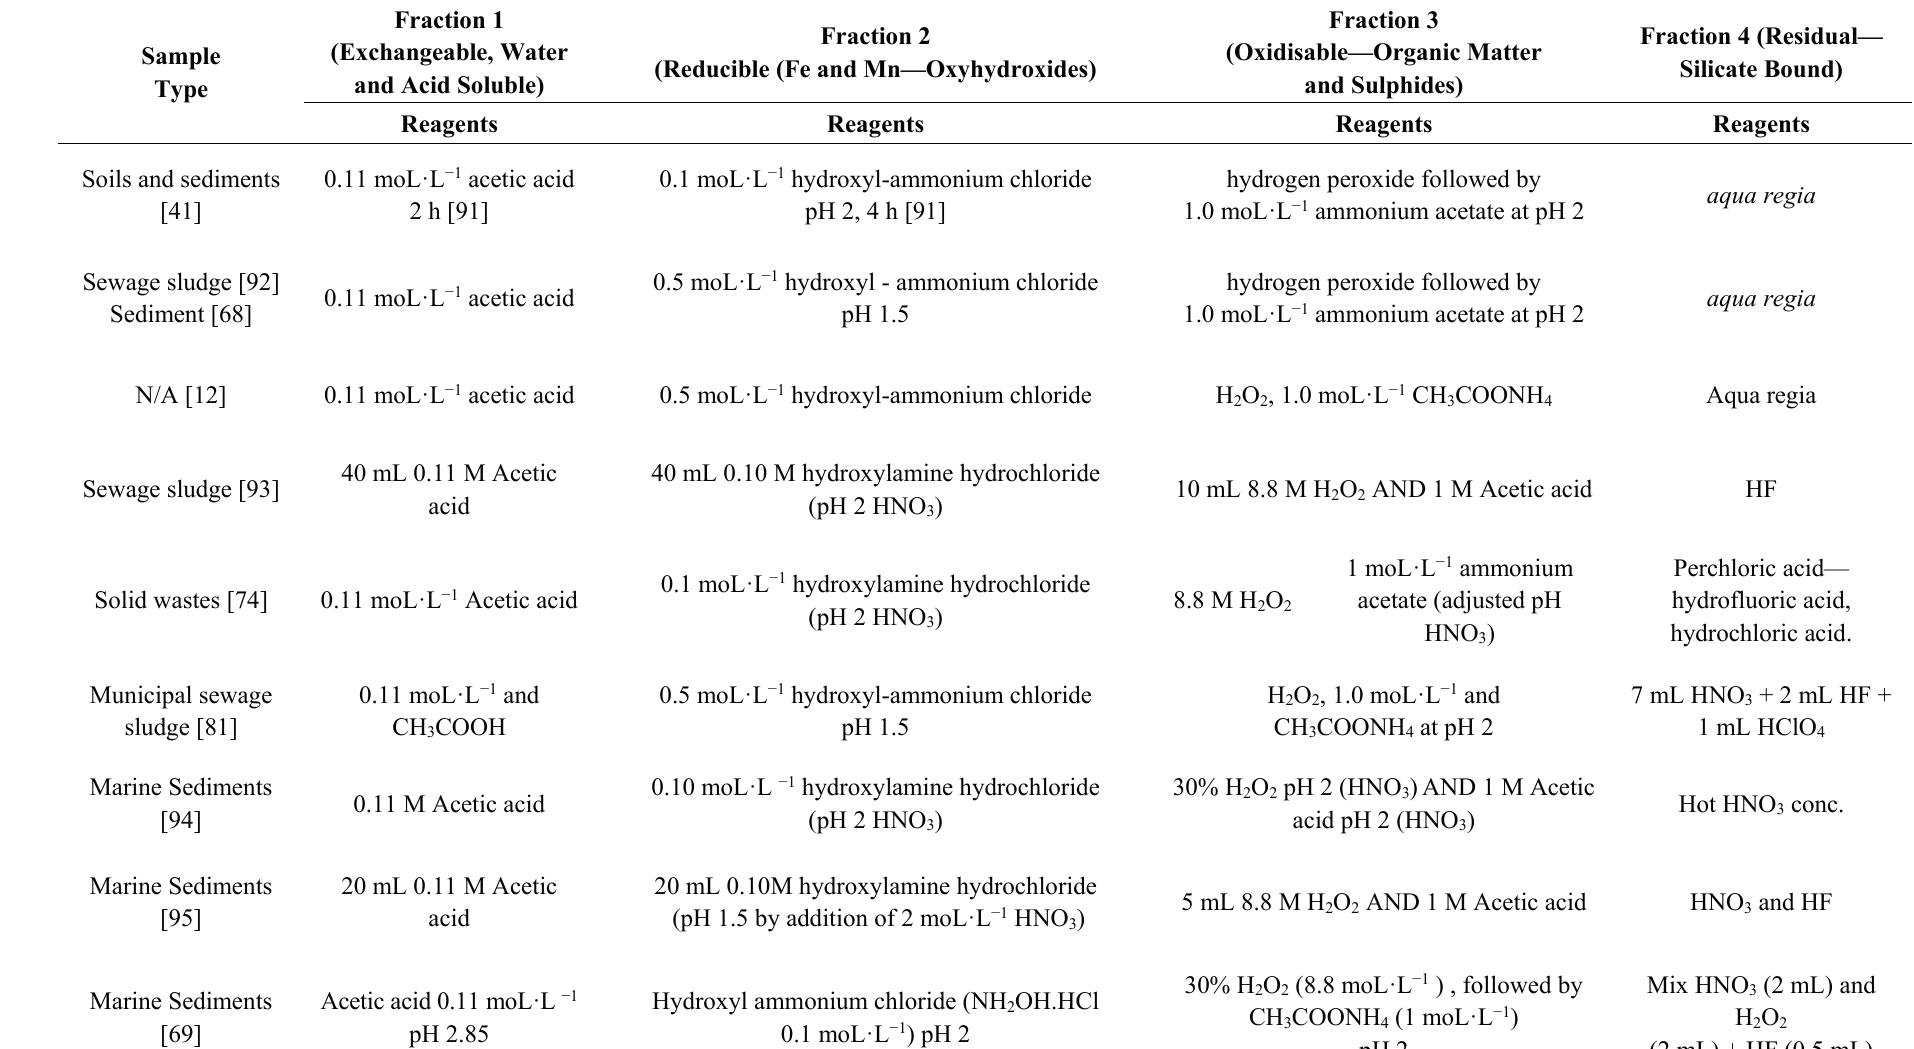
Table 4. Modifications of BCR sequential extraction procedure